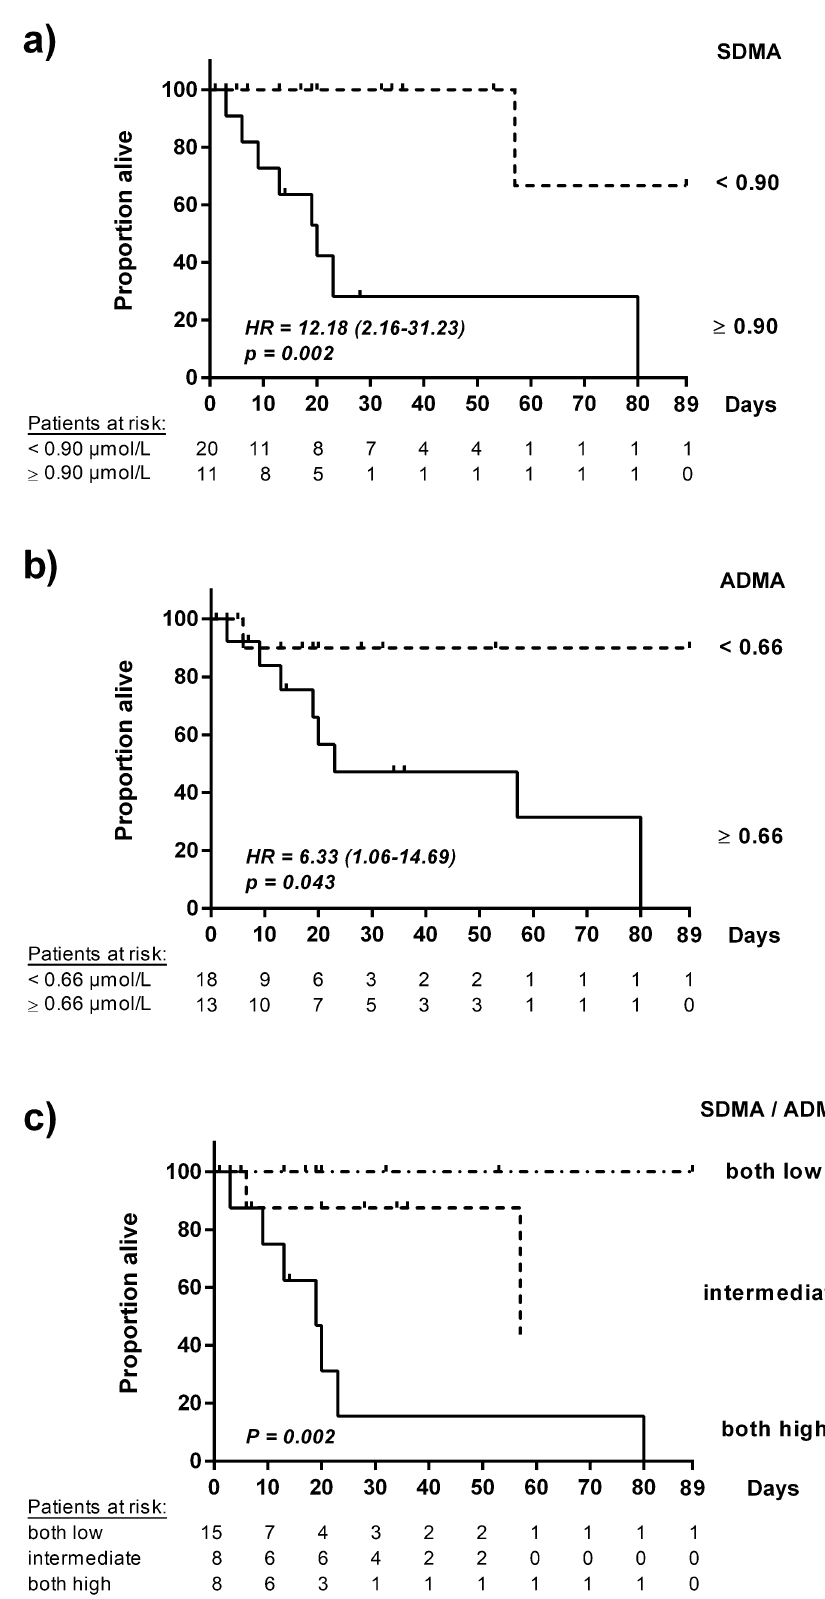
Figure 4. Kaplan–Meier curves for in-hospital mortality of hospitalized COVID-19 patients stratified for biomarker concentrations (N = 31): SDMA ( a ), ADMA ( b ), sequential quantification of SDMA and ADMA ( c ). The x-axis displays days after hospital